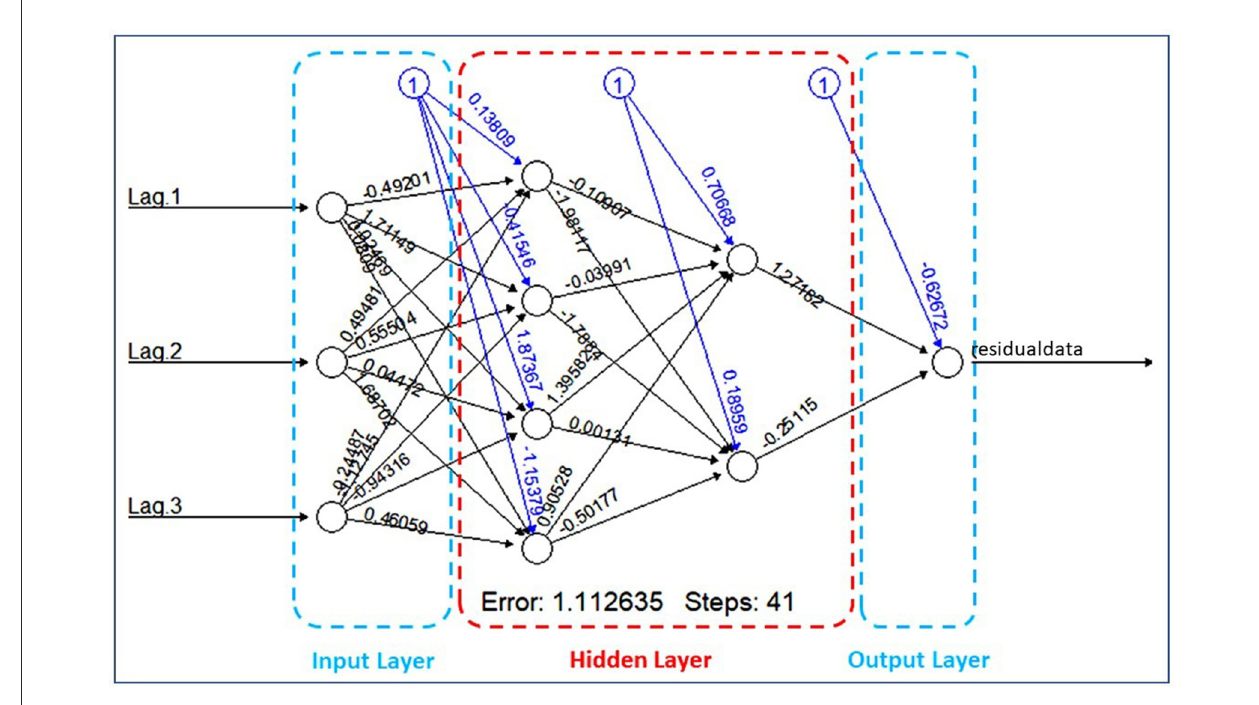
FIGURE6 Architecture 3 − 4 − 2 − 1 of FFNN model with their weights for each unit.